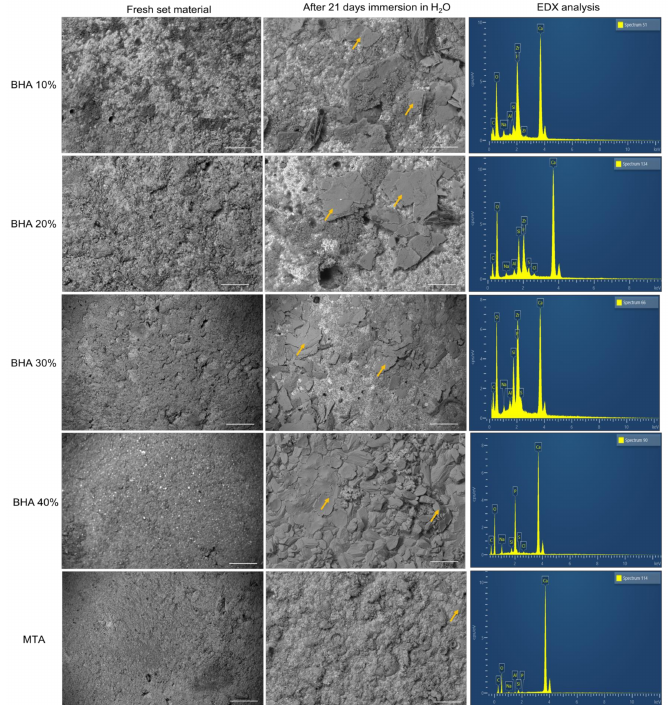
Figure 2. SEM images and their respective EDX analysis of the cements after initial set and 21 days immersion in H 2 O. Yellow arrows indicate apatite formation. (Error bar = 10 µ